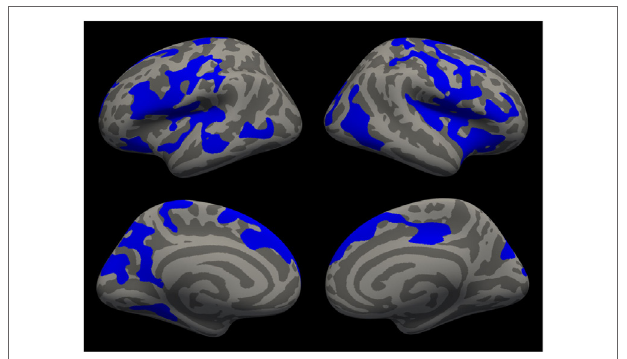
gray matter volumes for all patients ( n = 64). After Bonferroni correction for multiple comparisons, the volumes of left and right putamen, left and right pallidum, left and right accumbens, and right caudate were significantly associated with age at a corrected p < 0.05/12 = 0.004. The volumes of left and right hippocampus as well as left and right amygdala were not associated with age, even at an uncorrected p <